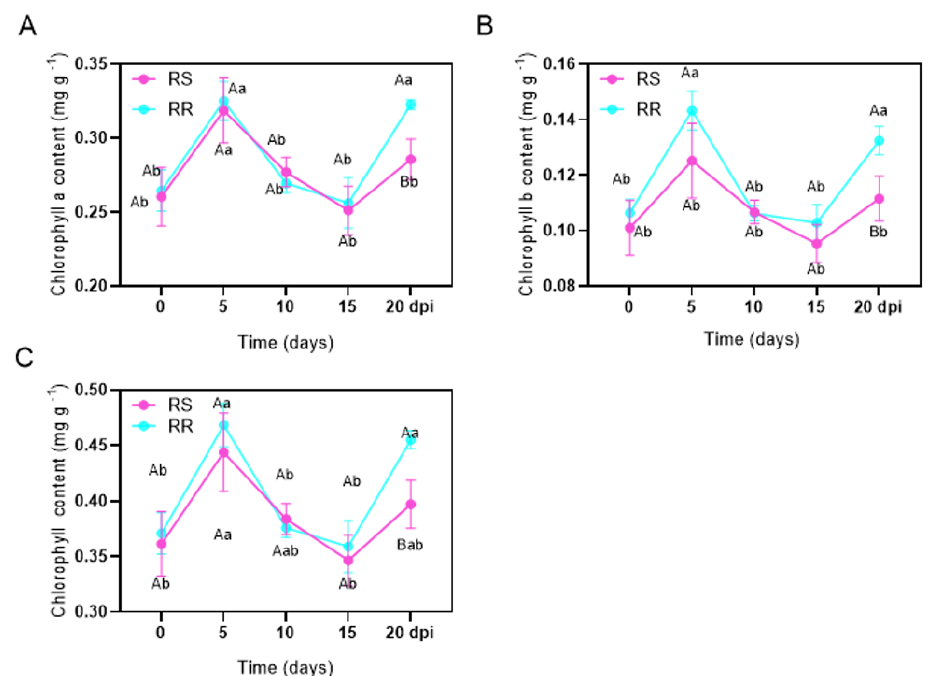
Figure 7. Change in chlorophyll content in rust-resistant Z. japonica (RR) and rust-susceptible Z. japonica (RS) after inoculation with P. zoysiae ( A – C ). Different lowercase letters mean significant difference among different days in the same material at p < 0.05. Different capital letters indicate significant difference between the two materials at a given date at p < 0.05.